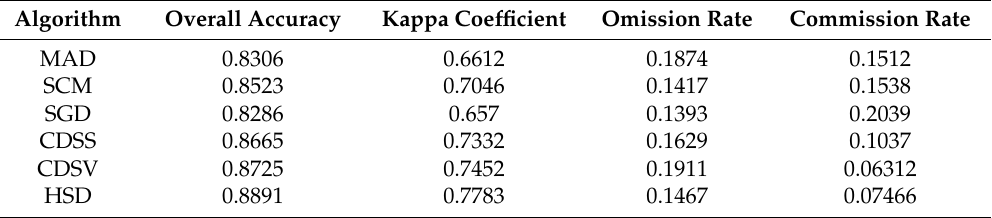
Table 3. The values of the accuracy features and the thresholds of different algorithms when they obtained their highest kappa coefficients.